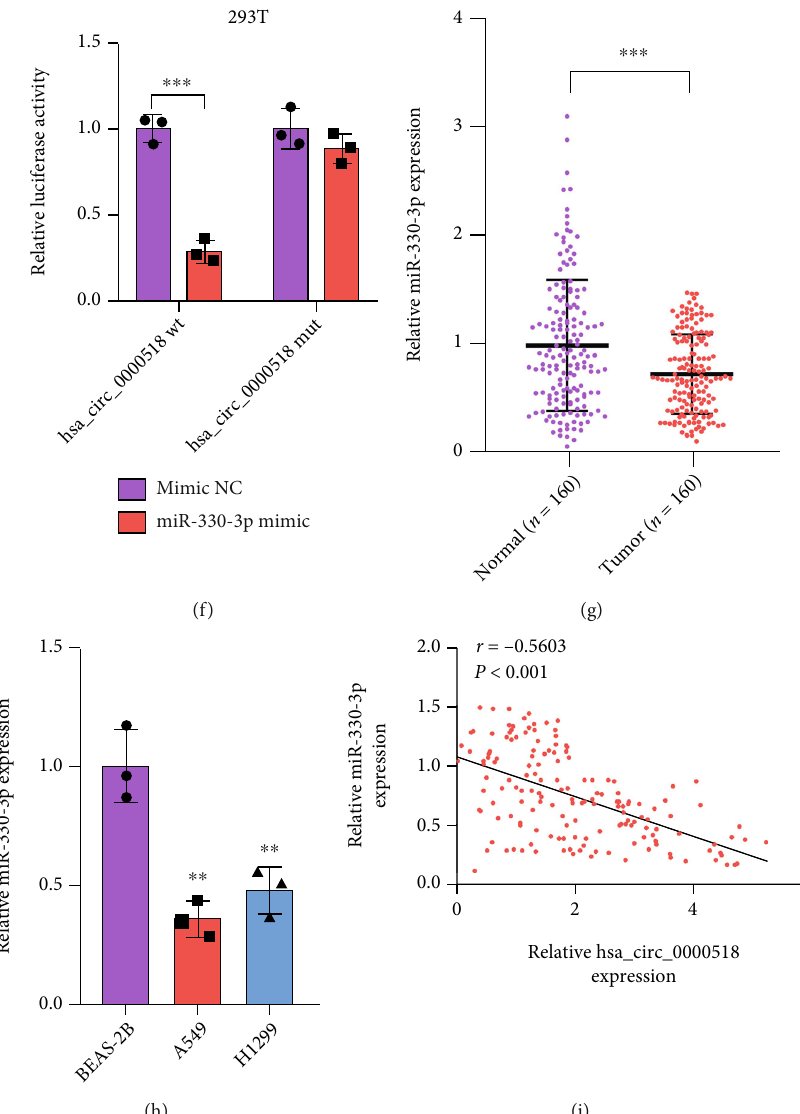
Figure 3: circ_0000518 had a negative correlation with miR-330-3p. (a) miRNAs were computationally predicted using CircInteractome and ENCORI databases. (b) Di ff erences in miRNA expression in tumor and normal tissues. (c) Detections of the targeted microRNAs (miR-326, miR-330-3p, and miR-1296-5p) in di ff erent cancer cell lines. (d) The binding sites of miR-330-3p with wt or mut circ_ 0000518 3 ′ UTR are shown schematically. (e) Enrichment levels of circ_0000518 and miR-330-3p extracted from Ago2 protein were analyzed by RIP. (f) Luciferase reporter assay of 293T cells cotransfected with circ_0000518-wt or circ_0000518-mut and miR-330-3p or the miR-330-3p-NC. (g) miR-330-3p expression levels in NSCLC vs. paired adjacent nontumor tissue ( n = 160 ). (h) The expression of miR-330-3p in NSCLC and normal cell line was measured by qRT-PCR. (i) circ_0000518 expression was negatively correlated with miR- 330-3p expression. ∗ p < 0 : 05 , ∗∗ p < 0 : 01 , ∗∗∗ p < 0 : 001